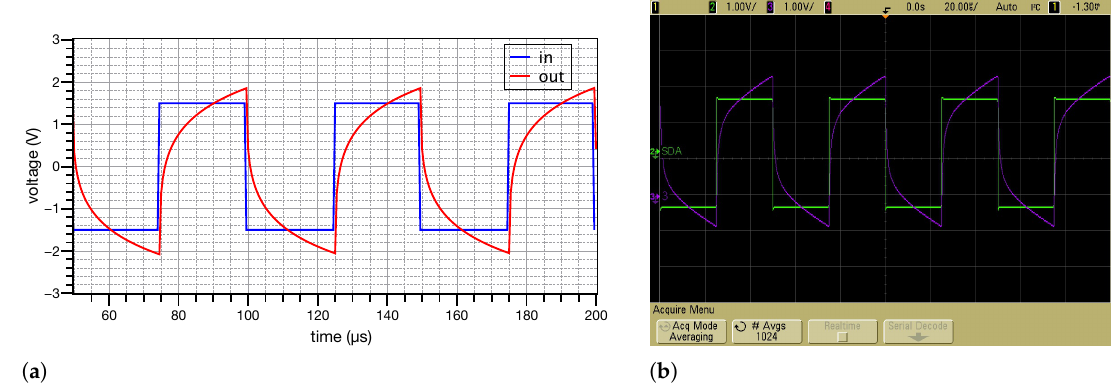
Figure 10. Input and output waveforms of a fractional-order integrator of order 0.26, realized by the topology in Figure 2b, for a square wave (3 V p-p , 20 kHz) stimulus ( a ) theoretical, and ( b ) experimental.